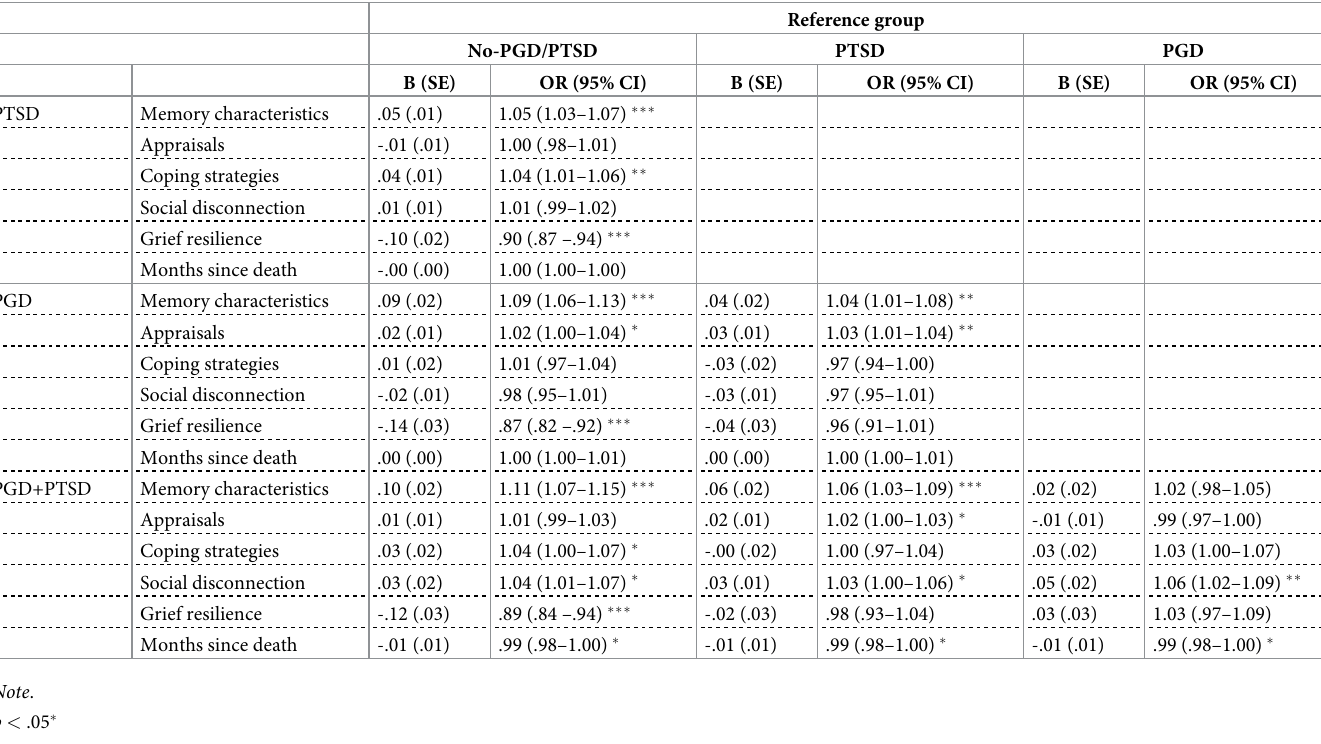
Table 4. Multivariate parameter estimates of group comparisons for months since loss and cognitive predictor variables.